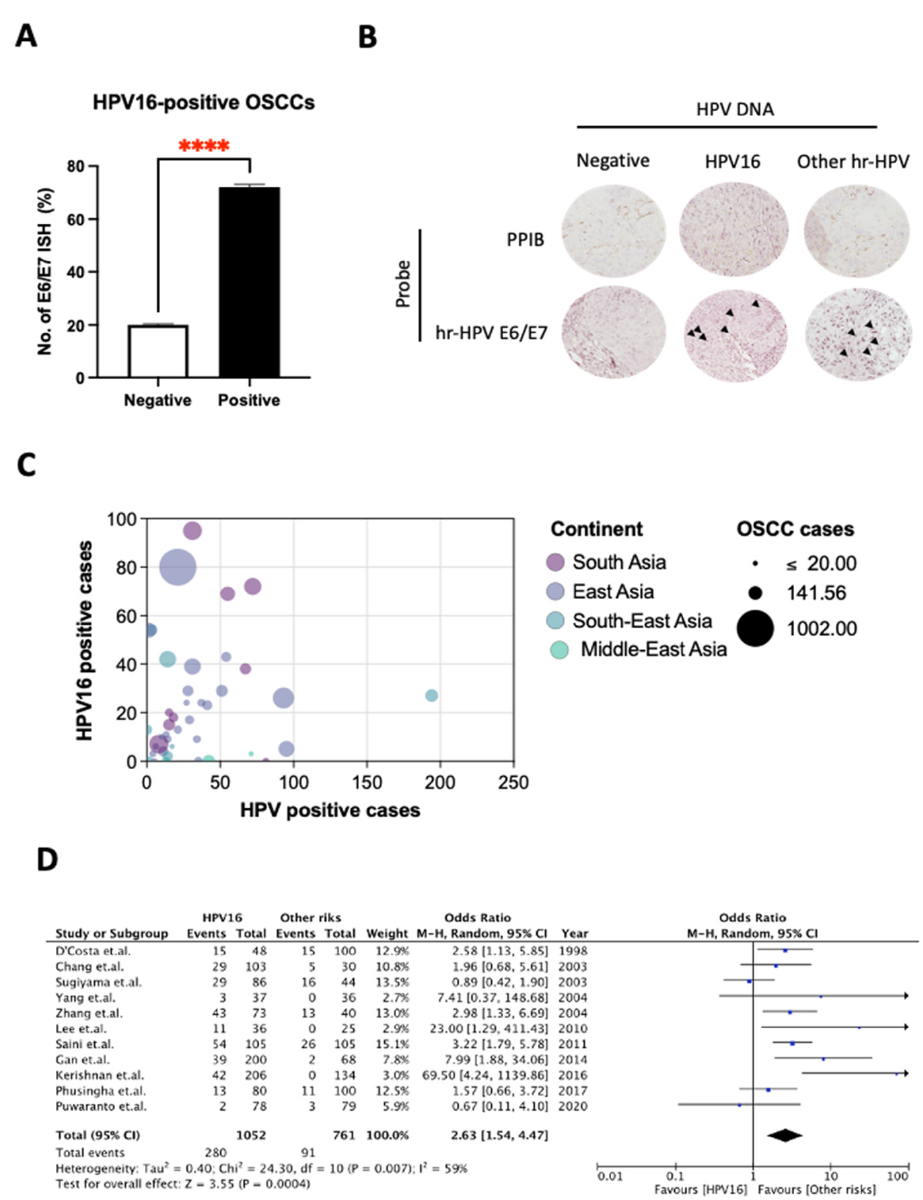
Figure 2. Comparison of presence of high-risk HPV among OSCC patients versus healthy individuals from different Asian studies. ( A , B ) The percentage of HPV16 in OSCC (FFPE) samples ( n = 146), was assessed by E6/E7 mRNA ISH assay (RNAscope ® HPV kit, Advanced Cell Diagnostics Inc., Newark, CA, USA). All experiments were carried out in triplicate, and at least three independent experiments were performed. ( C ) The prevalence of HPV DNA and HPV16 in OSCC by geographical region in Asia. Filled circles correspond to study-specific prevalence. Sizes of filled circles and unfilled circles are proportional to the number of cases. ( D ) Forest plot of the association between HPV16 infection and OSCC risk. **** p ≤ 0.0001.